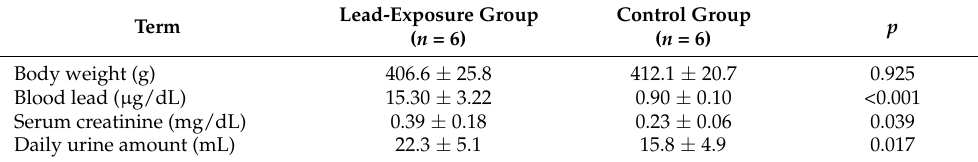
Table 1. Body weight, urine amount, and biochemical data in lead-exposure and control animals.